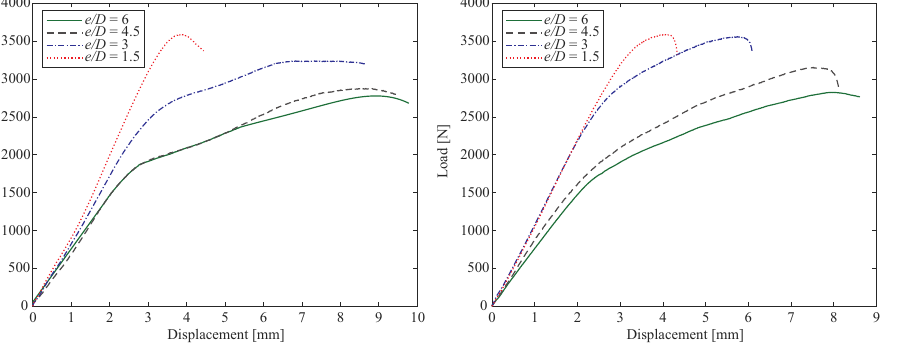
Figure 8. Load-displacement curves of examined PLA ( left ) and ABS ( right ) with different e / D